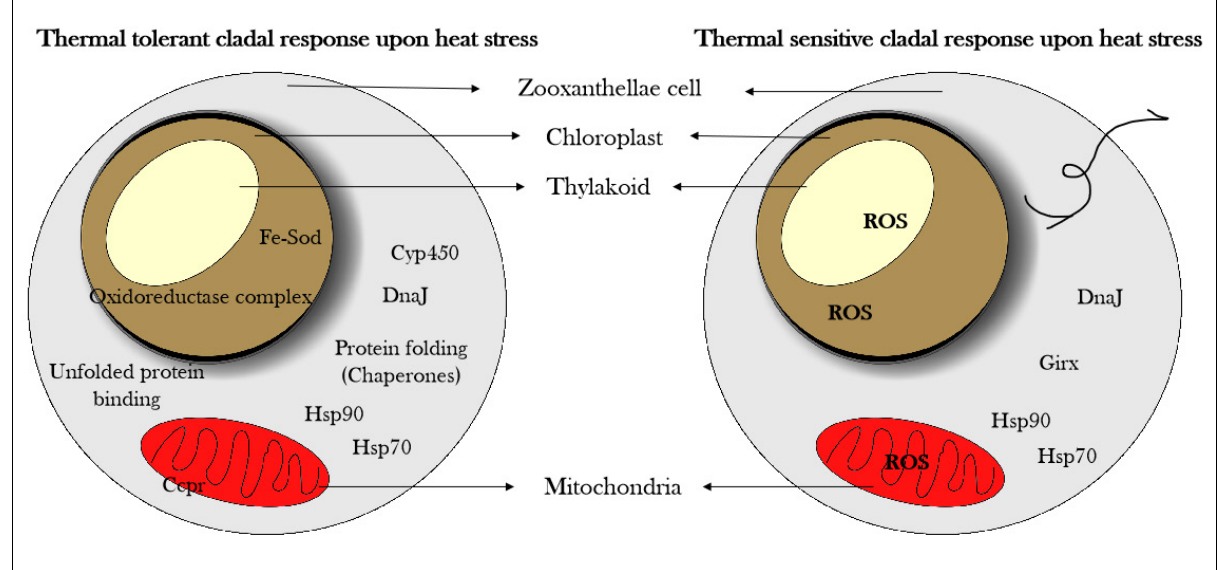
Figure 1: Protective mechanisms that are induced to actively counteract heat/thermal stress within both sensitive and tolerant zooxanthellae species according to Levin et al.